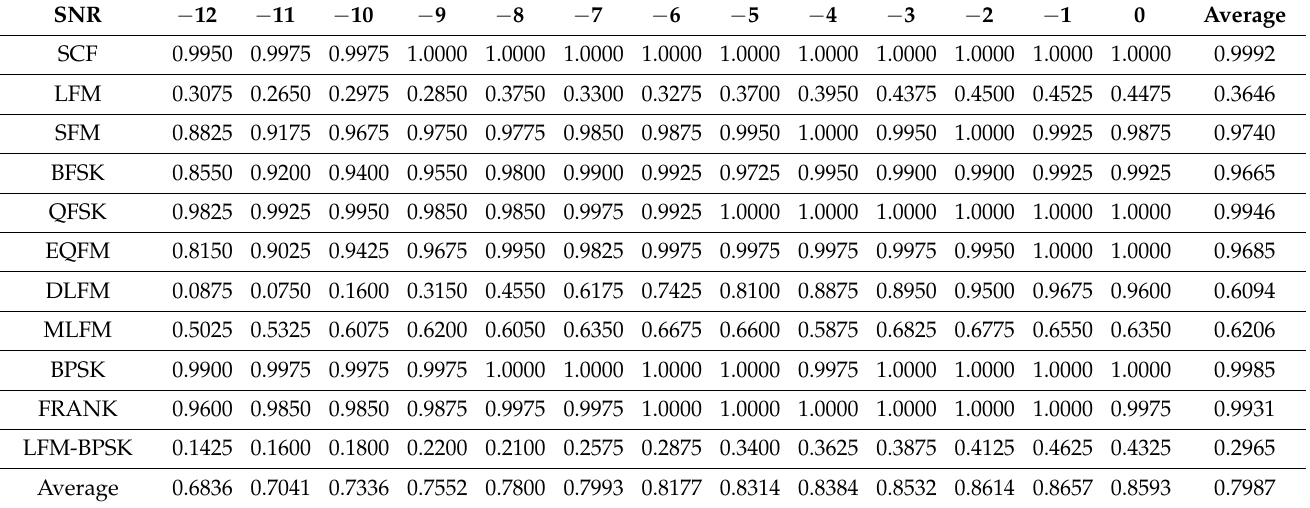
Table A15. Semi-supervised classification results with the datasets in Situation Dataset 5 without self-paced data augmentation ( T cycle = 50, NUM = 1102).